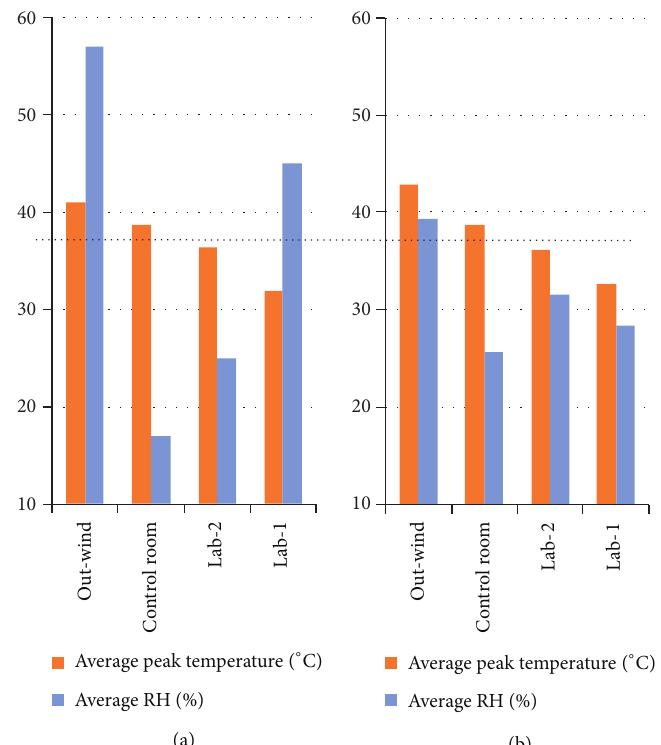
Figure 6: Peak temperatures and RH of respective environments, (a) wet season and (b) dry season. Broken line shows the critical threshold of 37.4 ∘ C above which neonatal hyperthermia could set in.